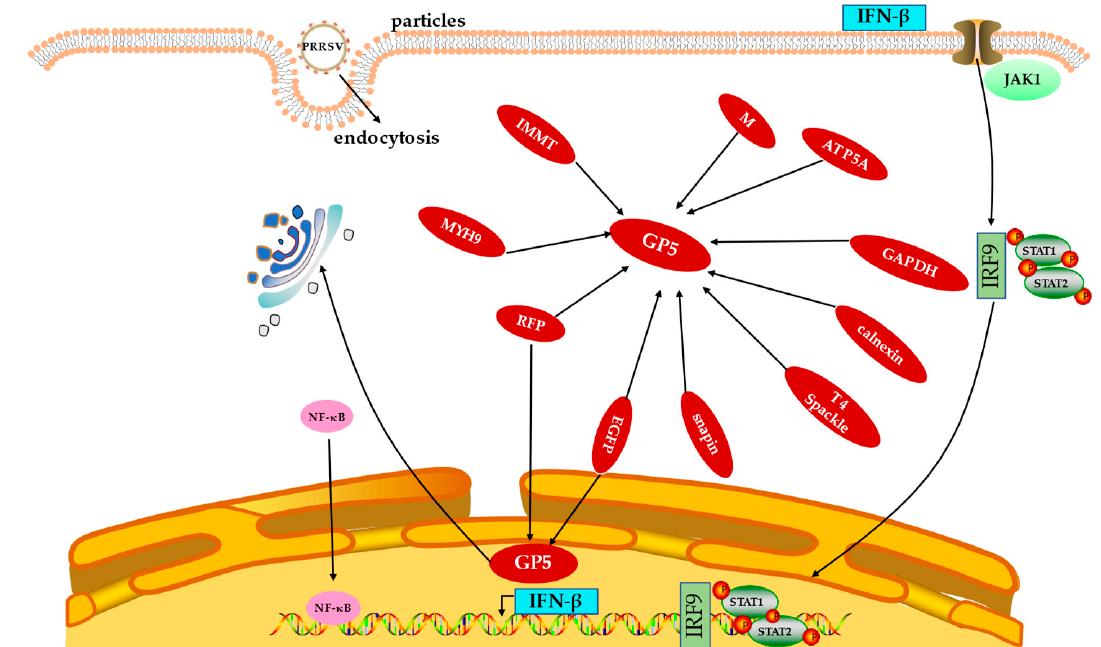
Figure 4. Interactions between PRRSV GP5 protein and host proteins. Abbreviations: GP5, glyco- protein 5; IFN- β , interferon β ; PRRSV, porcine reproductive and respiratory syndrome virus; EGFP, enhanced green fluorescent protein; RFP, red fluorescent protein; MYH9, myosin heavy chain 9; GAPDH, glyceraldehyde 3-phosphate dehydrogenase; ATP5A, ATP synthase subunit alpha; IRF9, interferon regulatory factor 9; NF- κ B, nuclear factor κ B.